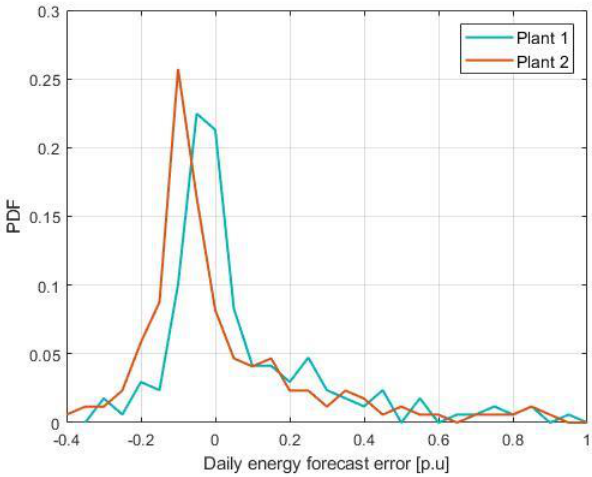
Figure 9. PDF of the daily energy relative forecast error, with respect to the energy produced.